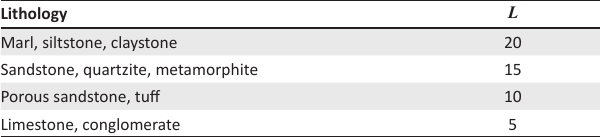
TABLE 2: Effective water capacity for topsoil classification.